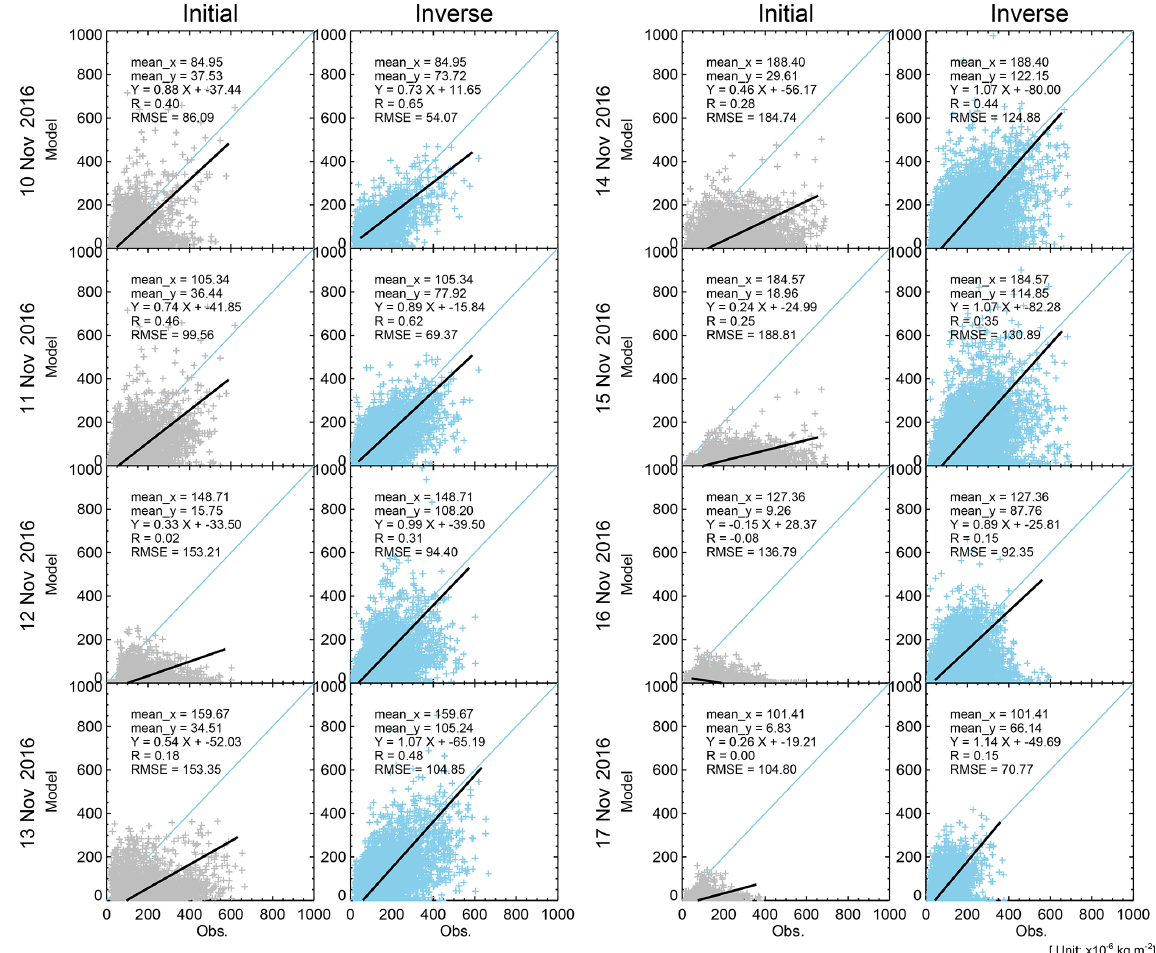
Figure 4. Scatterplot comparison between initial and assimilated smoke mass loading using adjusted fire emissions. A 48h observation (aday =− 1) and 6-layer plume release configuration is used (unit: × 10 − 6 kgm − 2